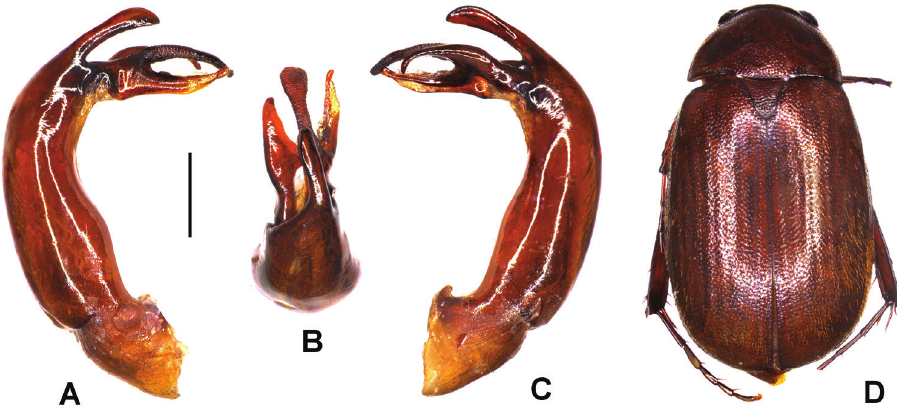
Figure 2. A–D Neoserica radhanagariensis sp. n. (holotype) A aedeagus, left side lateral view C aedeagus, right side lateral view B parameres, dorsal view D habitus. Scale bar: 0.5 mm. Habitus not to scale. Elytra elongate, widest in posterior third; striae weakly impressed, finely punctate, intervals flat, finely, evenly and densely punctate, with fine and dense, short setae being fine membranous rim.